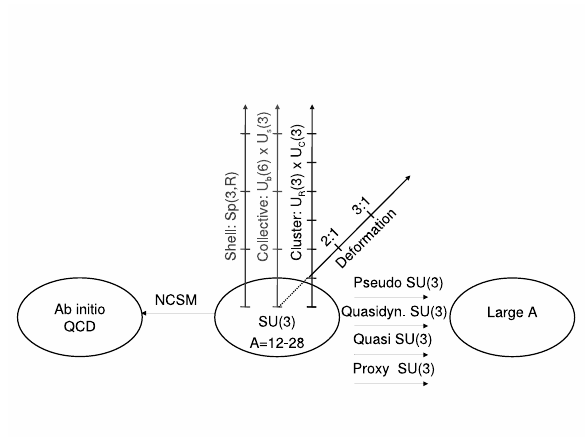
Figure 1. Some extensions of Elliott’s SU(3) symmetry (central part) along di ff erent directions: mass number (horizontal) exci- tation energy (vertical), deformation